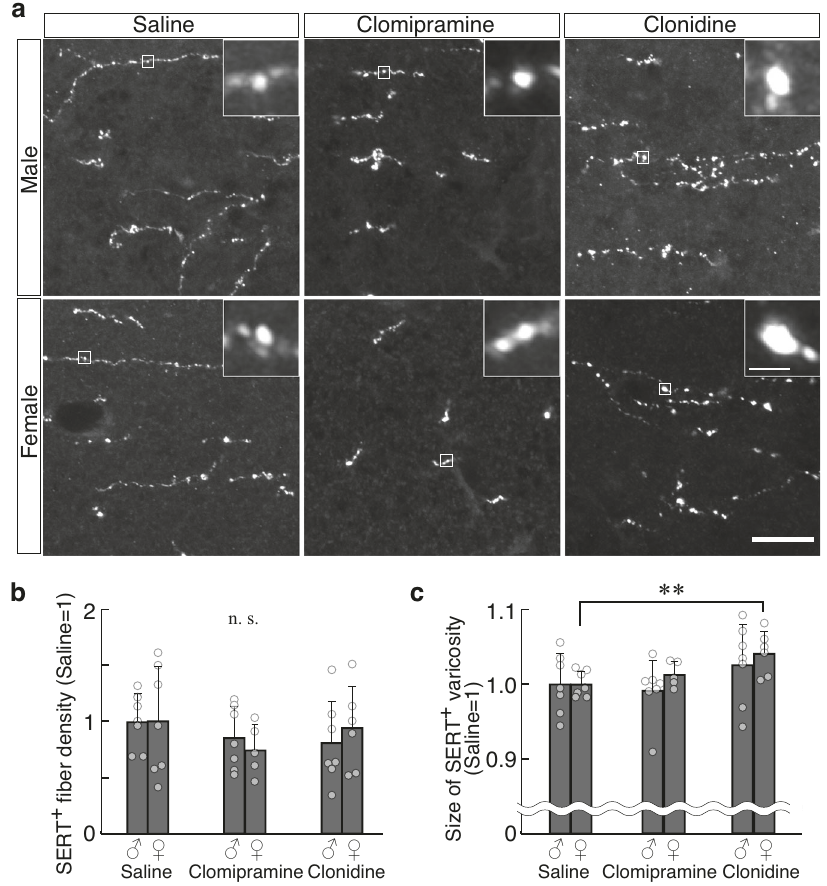
Fig. 5 Effects of clomipramine or clonidine treatment on infantile serotonergic fi ber morphology. a Representative images of the serotonergic fi bers in the PFC of P7 mice treated with saline, clomipramine (15 mg/kg/day), and clonidine (0.1 mg/kg/day) during P3 – P6. The fi ber density ( b ) and varicosity size ( c ) of SERT + fi bers were compared with those of saline-treated samples. Male, n = 7, 7, 7; female, n = 7, 5, 6 (saline, clomipramine, clonidine, respectively). In both analyses, the mean value for the saline-treated mice was de fi ned as 1. Scale bar , 10; 1 µ m (inset). Data were presented as mean ± SD. ** P < 0.01 in Dunnett ’ s